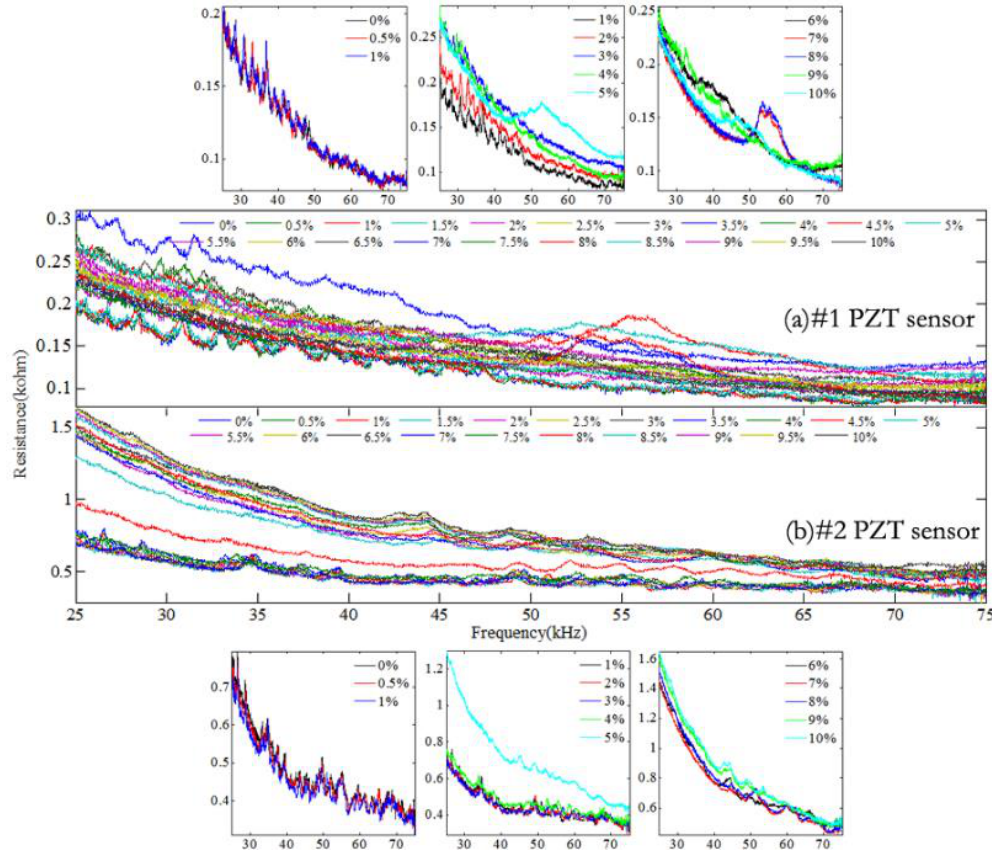
Figure 6. Resistance vs. frequency spectra for PZT transducers in the frequency range of 25–75 kHz.